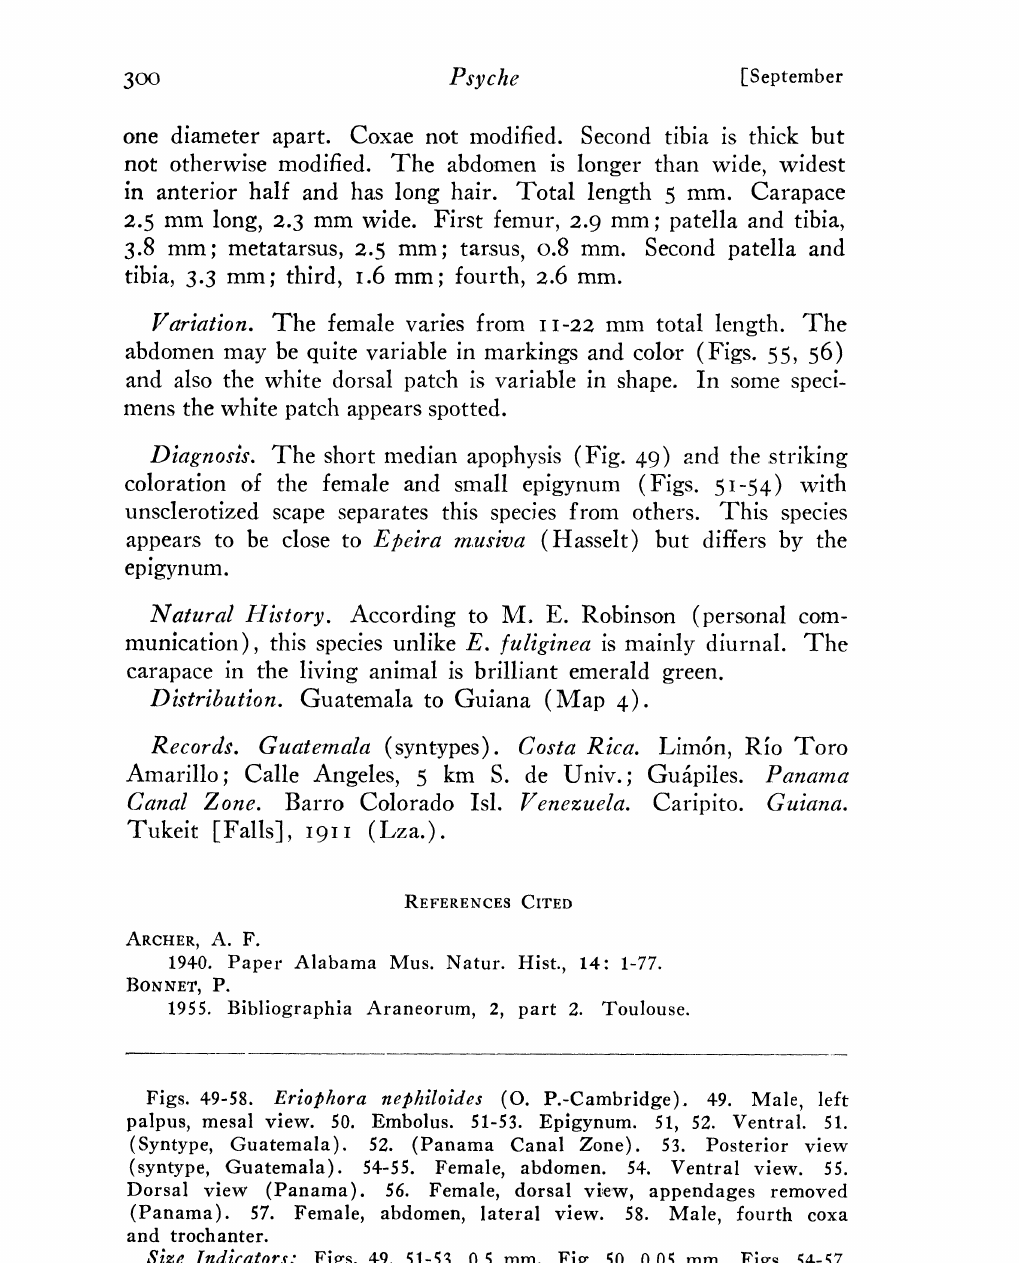
Figs. 49-58. Erlophora nephiloides (O. P.-Cambridge). 49. Male, left palpus, mesal view. 50. Embolus. 51-53. Epigynum. 51, 52. Ventral. 51. (Syntype, Guatemala). 52. (Panama Canal Zone). 53. Posterior view (syntype, Guatemala). 54-55. Female, abdomen. 54. Ventral view. 55. Dorsal view (Panama). 56. Female, dorsal vie’w, appendages removed (Panama). 57. Female, abdomen, lateral view. 58. Male, fourth eoxa and troehanter. Size Indicators: Figs. 49, 51-53, 0.5 mm. Fig. 50, 0.05 mm. Figs. 54-57,